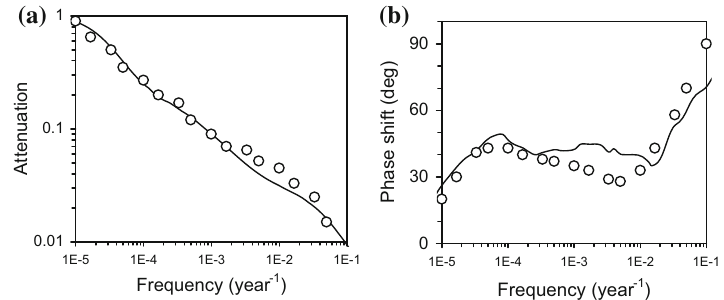
Fig. 12 The frequency characteristics of the carbon cycle: attenuation ( left -hand panel) and phase shift ( right -hand panel) as a function of the frequency of the 14 C production signal. Lines stand for a classical Oeschger–Siegenthalerboxmodel(Siegenthaleretal.1980),and opencircles forasophisticatedPANDORA model (Bard et al.